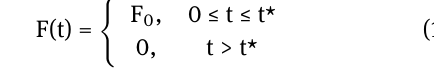
algorithm for a general dynamic analysis with contact de- scribed in Section 2.5. The models with rectangular debond- ing were loaded with a concentrated harmonic force F( t ) = F 0 sin Ωt subjected at the central point of the upper face- plate. The dynamic response of the model was investigated for fixed excitation amplitude F = 100 N by varying the 0 excitation frequency ( Ω